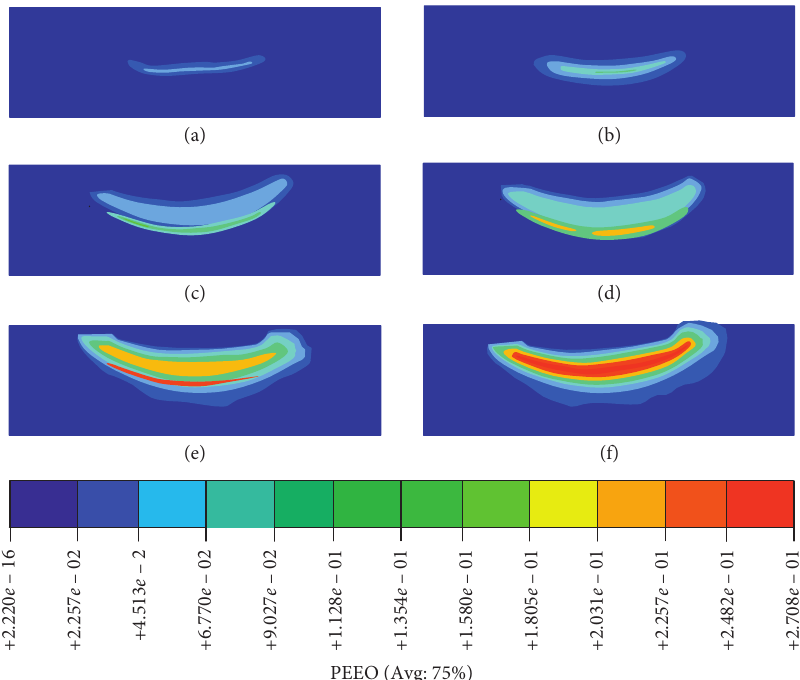
Figure 7: Rotary piercing simulation results of solid-state processing of metal materials. (a) Stage (1). (b) Stage (2). (c) Stage (3). (d) Stage (4). (e) Stage (5). (f) Stage